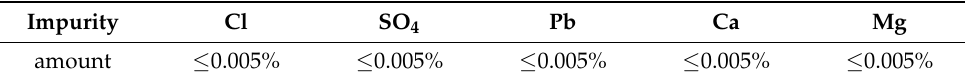
Table 1. Impurity levels in the quartz powders (data provided by supplier, wt.%).